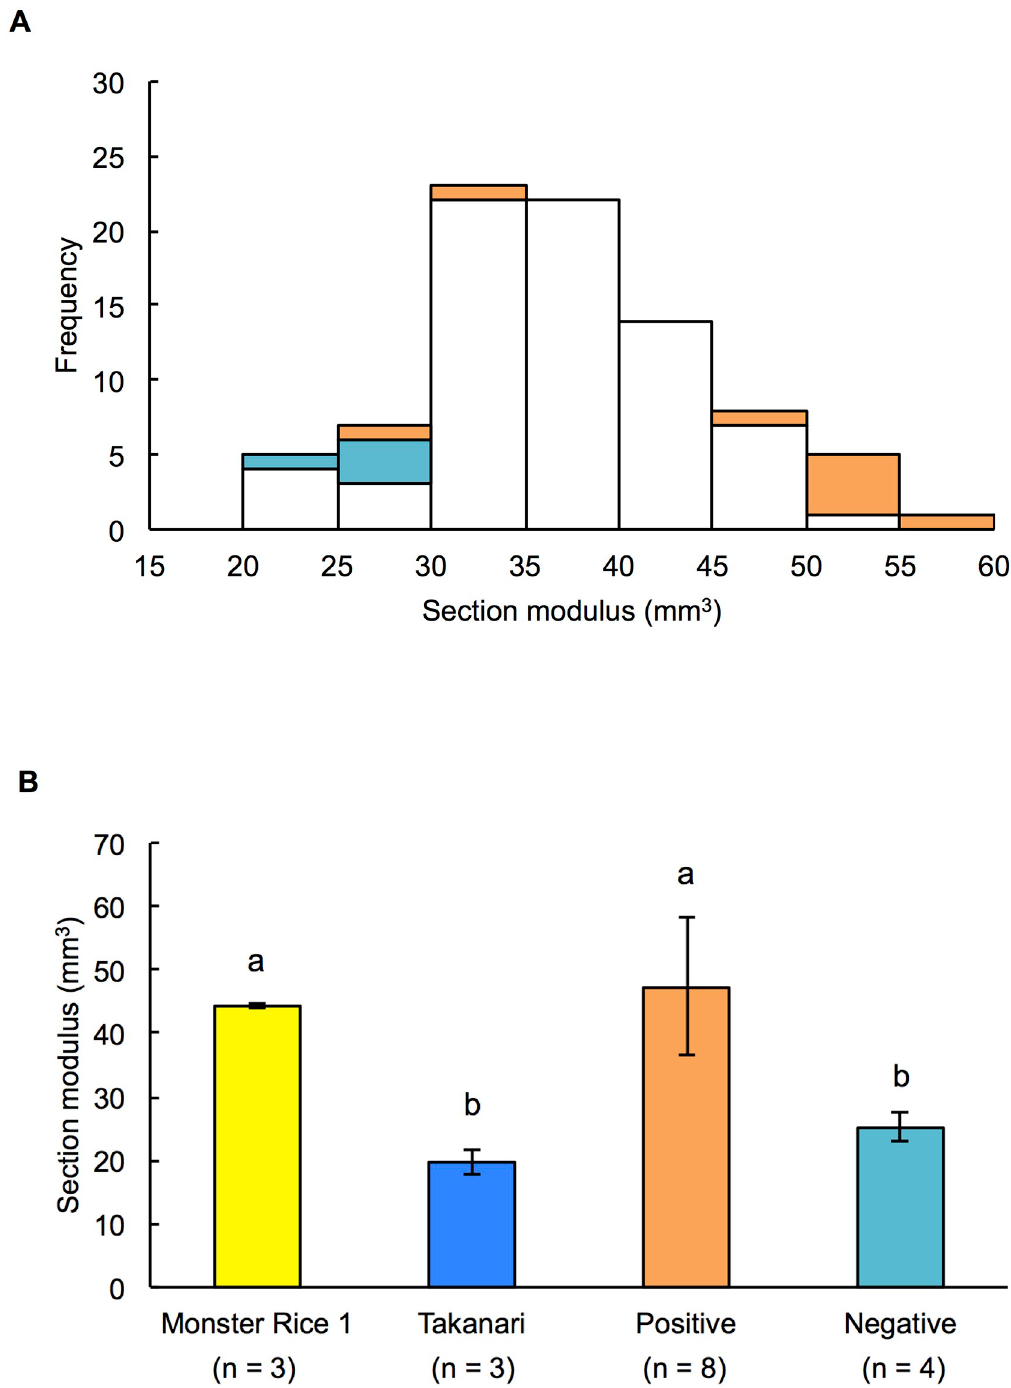
Fig 5. Combined effect of QTLs for section modulus in RILs. (A) Frequency distribution of section modulus. Orange bar, the lines combined with the three positive QTLs; light blue bar, the lines combined with three negative QTLs; white bar, the other lines. Blue and yellow arrows indicate mean of Takanari and Monster Rice 1, respectively. (B) Mean ± SD of section modulus of parental cultivars and lines with three positive or negative QTLs. Different alphabets indicate P < 0.05 (Tukey- Kramer